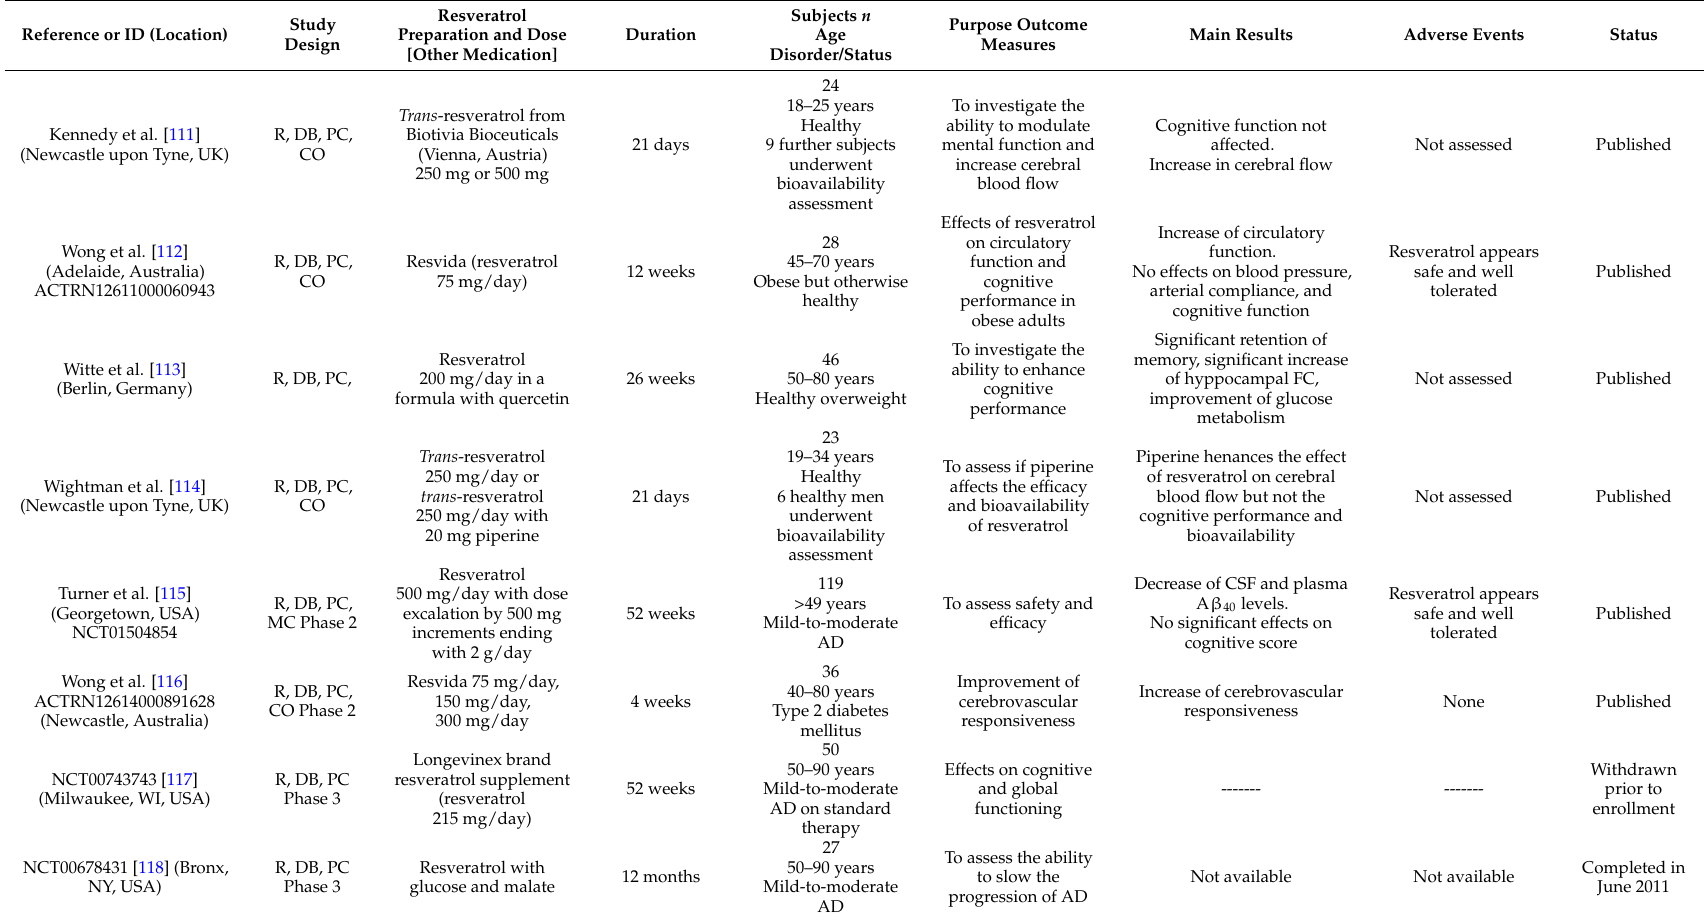
Table 2. Clinical trials on the effects of resveratrol on cognitive